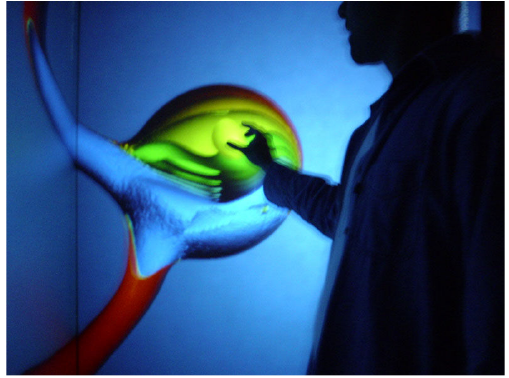
Figure 9. CAVE displaying blood vessels with flow speed in colours.